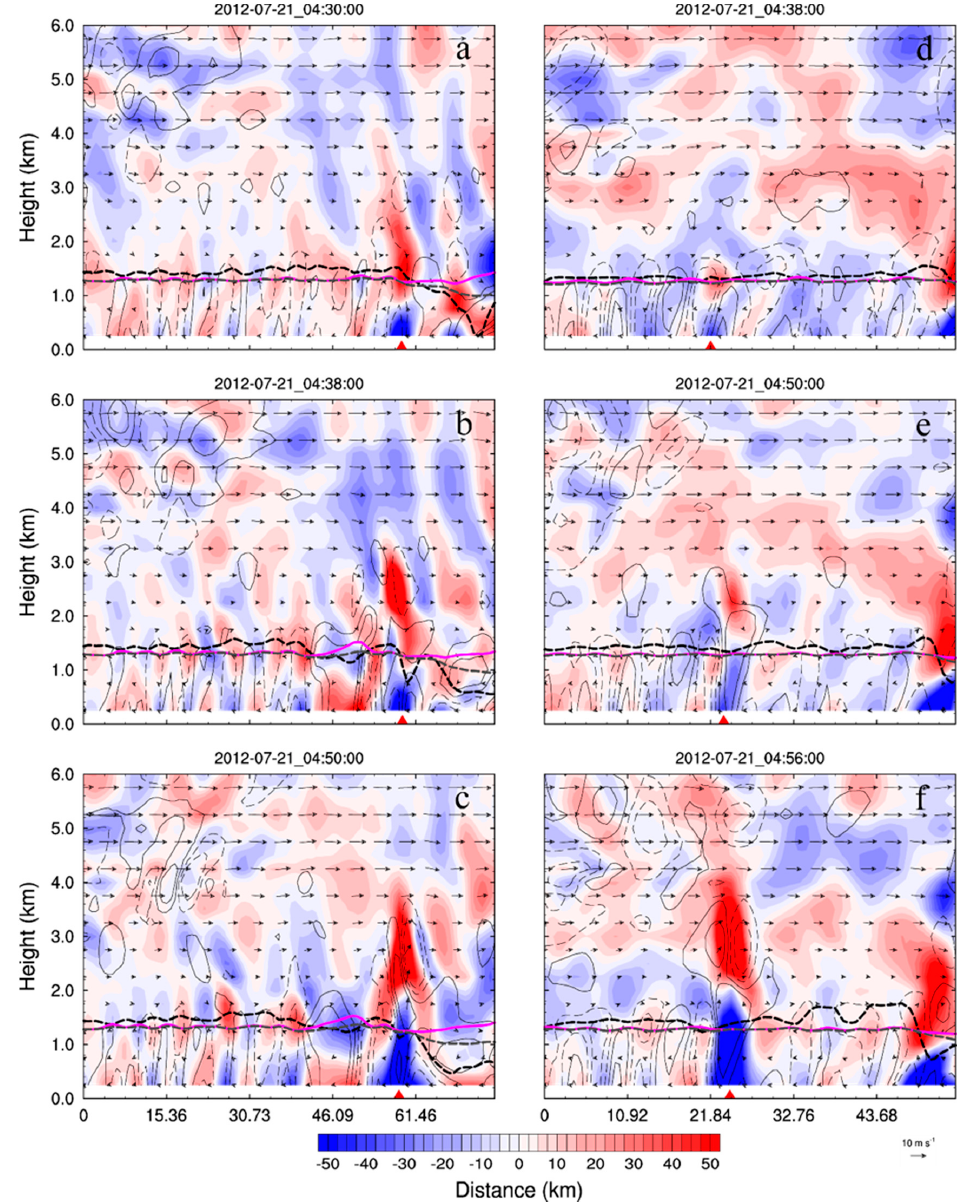
Figure 10. ( a – c ) Vertical cross sections of the simulated divergence field (shaded, units: 10 − 5 s − 1 ), the vorticity field (contoured, units: 10 − 5 s − 1 ), the wind field (vectors, units: m s − 1 ), the LCL (gray dotted line), the PBLH (black dotted line), and the LFC (red solid line) during the evolution of convective cell